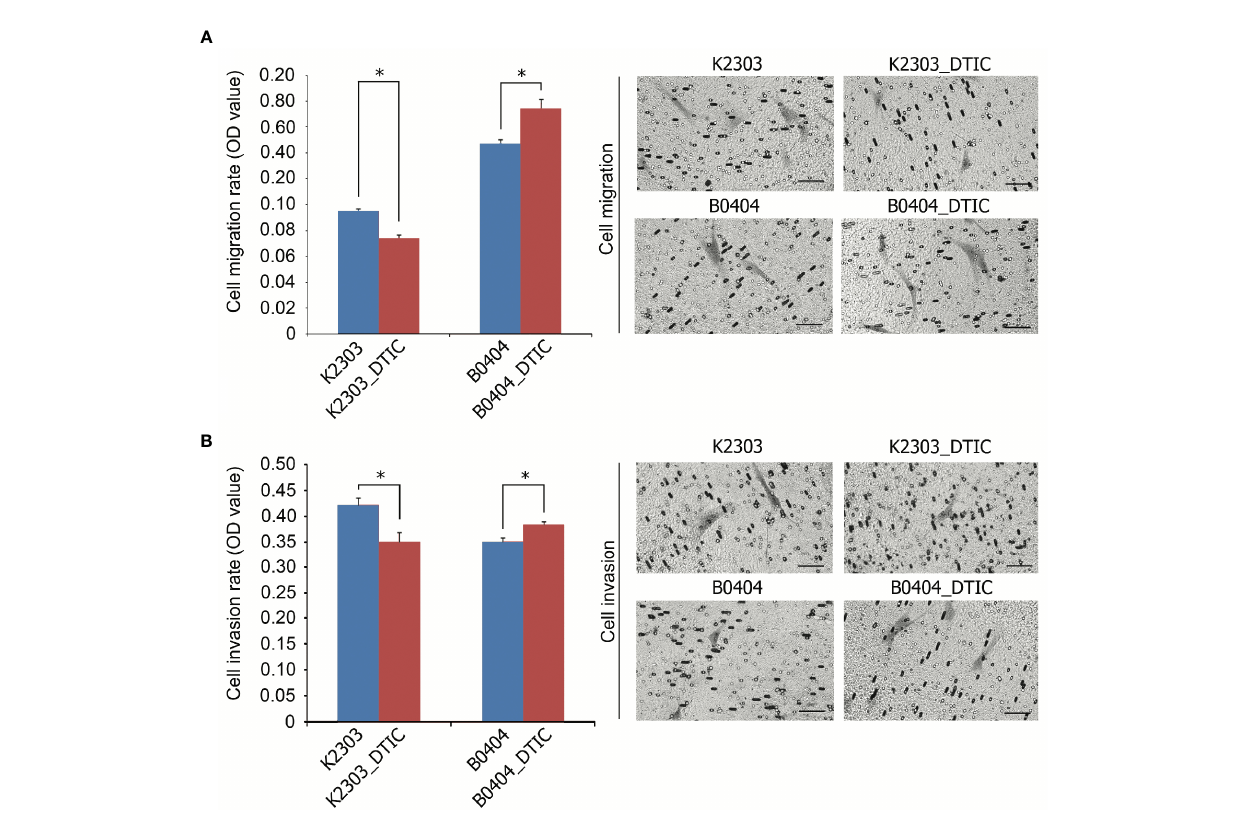
FIGURE 3 | Invasive and migratory potential of K2303 and B0404 melanoma cells after DTIC treatment. (A) Migration assay results of cells that were treated with 5.5 mM DTIC. Microscopic images of the polycarbonate membrane with migrated cells are shown. Migratory capacities of K2303 cells were reduced whilst B0404 cells exhibited increased cell migration. Data are presented as the mean±SEM. *P<0.05 by Mann-Whitney U test for unpaired samples. DTIC, dacarbazine (B) Invasion assay results of cells that were treated with 5.5 mM DTIC. Microscopic images of the polycarbonate membrane with invasive cells are shown. Invasion rate of K2303 cells was reduced whilst the level of invasion of B0404 was increased. Data are presented as the mean±SEM. *P<0.05 by Mann-Whitney U test for unpaired samples. DTIC,